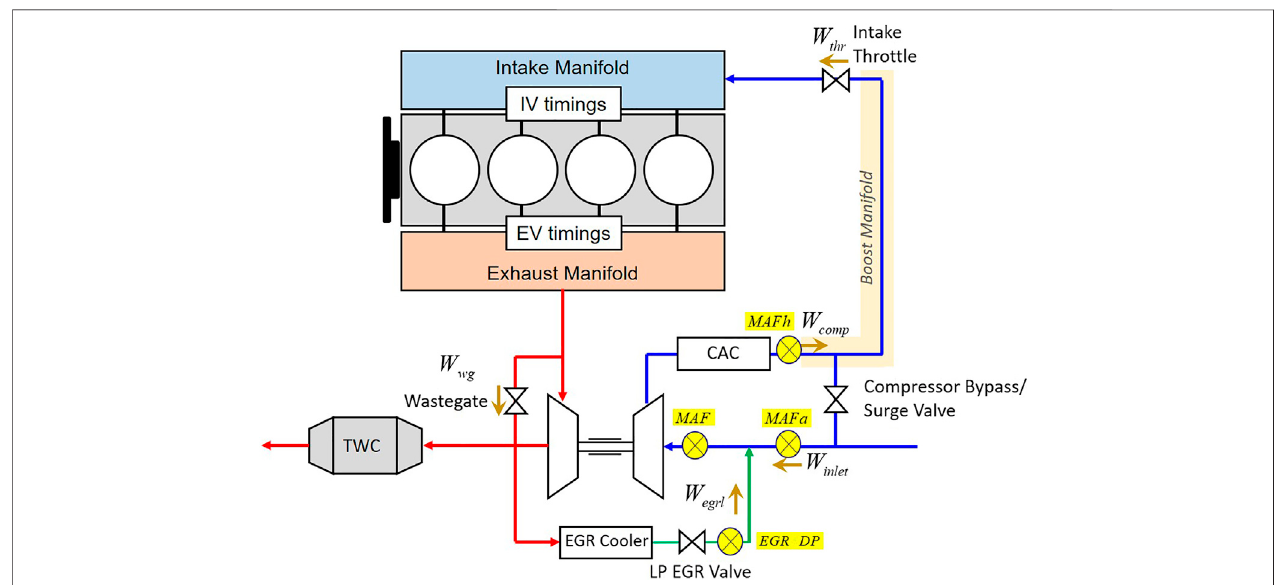
FIGURE 1 | Engine architecture and candidate sensor